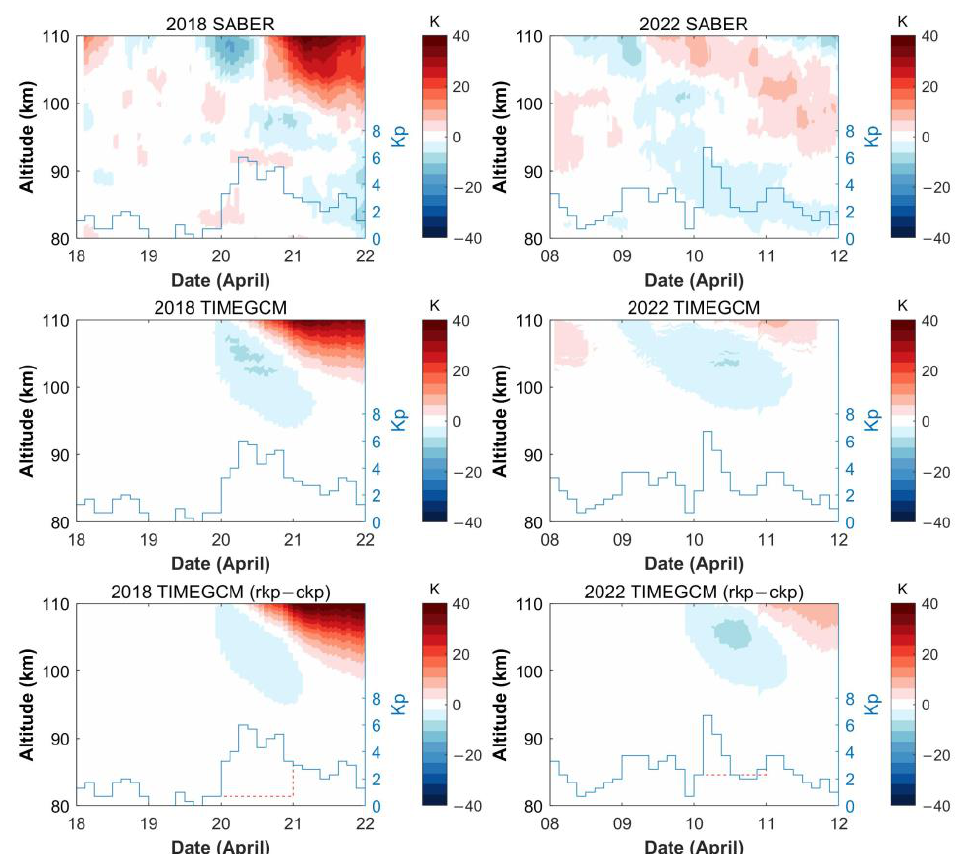
Figure 1. The difference between the zonal running SABER temperature (first row) during two geomagnetic storms in April 2018 (the left column) and April 2022 (the right column) and the average temperature of the two days before the storms (18–19 April 2018 and 8–9 April 2022, respectively) in the altitude ranges of 80–110 km from 77.5 ◦ S to 82.5 ◦ S. The second row is similar to the first row, but the data are simulated by TIMEGCM driven by real geomagnetic conditions (rkp). The third row shows the variations in temperature obtained by subtracting the simulation driven by constant geomagnetic conditions (ckp) from the simulation driven by real geomagnetic conditions (rkp). The blue lines are the real Kp values. The red lines are the quiet time Kp values as the driving condition of the ckp simulation. The two ckp are 1 + for 20 April 2018, and 2 − for 10 April 2022, respectively. Then the constant Kp values are set the same as the real ones.